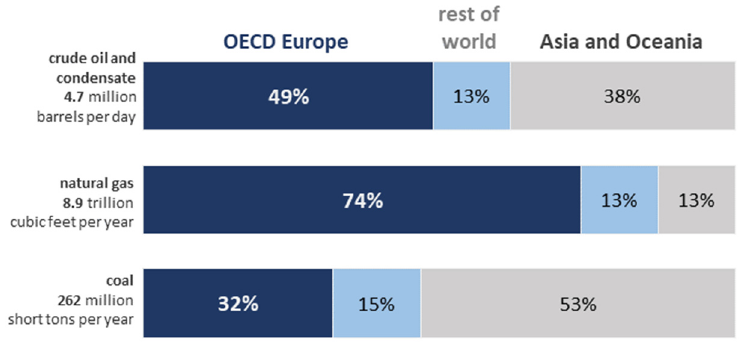
Figure 1. Key energy exports from Russia (2021). Source: [2].